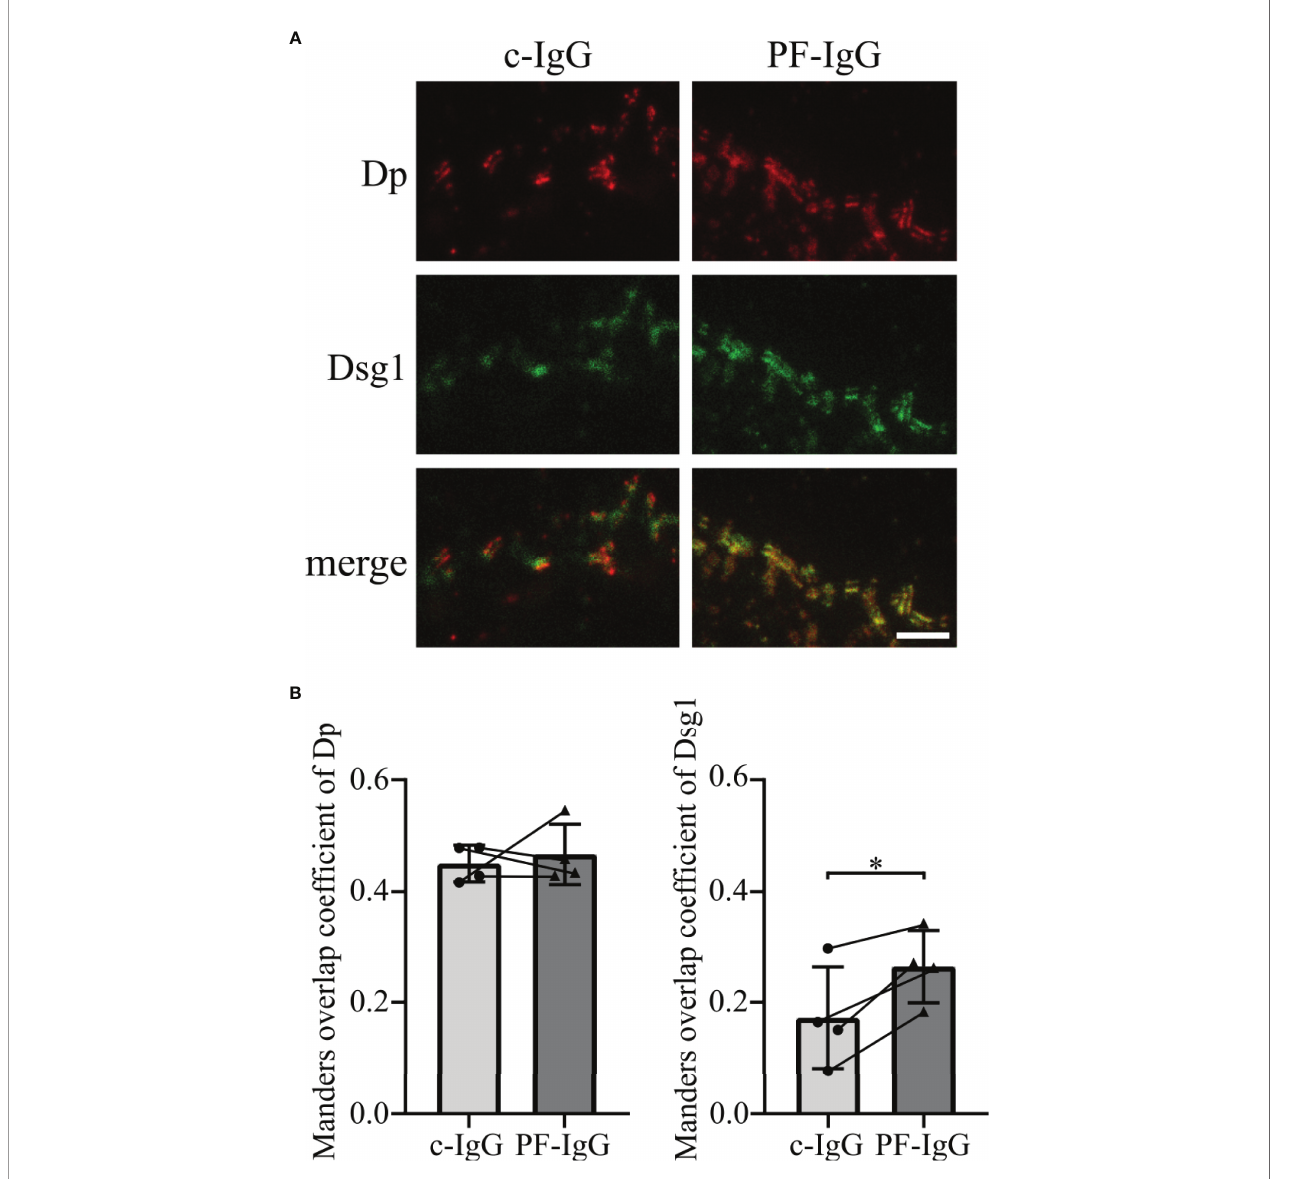
FIGURE 4 | Incubation of PF-IgG leads to redistribution of membrane-bound, overexpressed Dsg1 in HaCaT cells. (A) Representative immunostainings of HaCaT cells overexpressing desmoglein 1 (Dsg1) and incubated 24 h with IgG fractions, stained for desmoplakin (Dp) and overexpressed Dsg1. Scale bar: 1 µm. (B) Manders overlap coef fi cient of Dp with Dsg1 (left) and Dsg1 with Dp (right). N=4; each dot represents the mean of >5 acquisitions from one independent experiment. *P<0.05 in two-tailed paired Student ’ s t-test; error bars represent standard